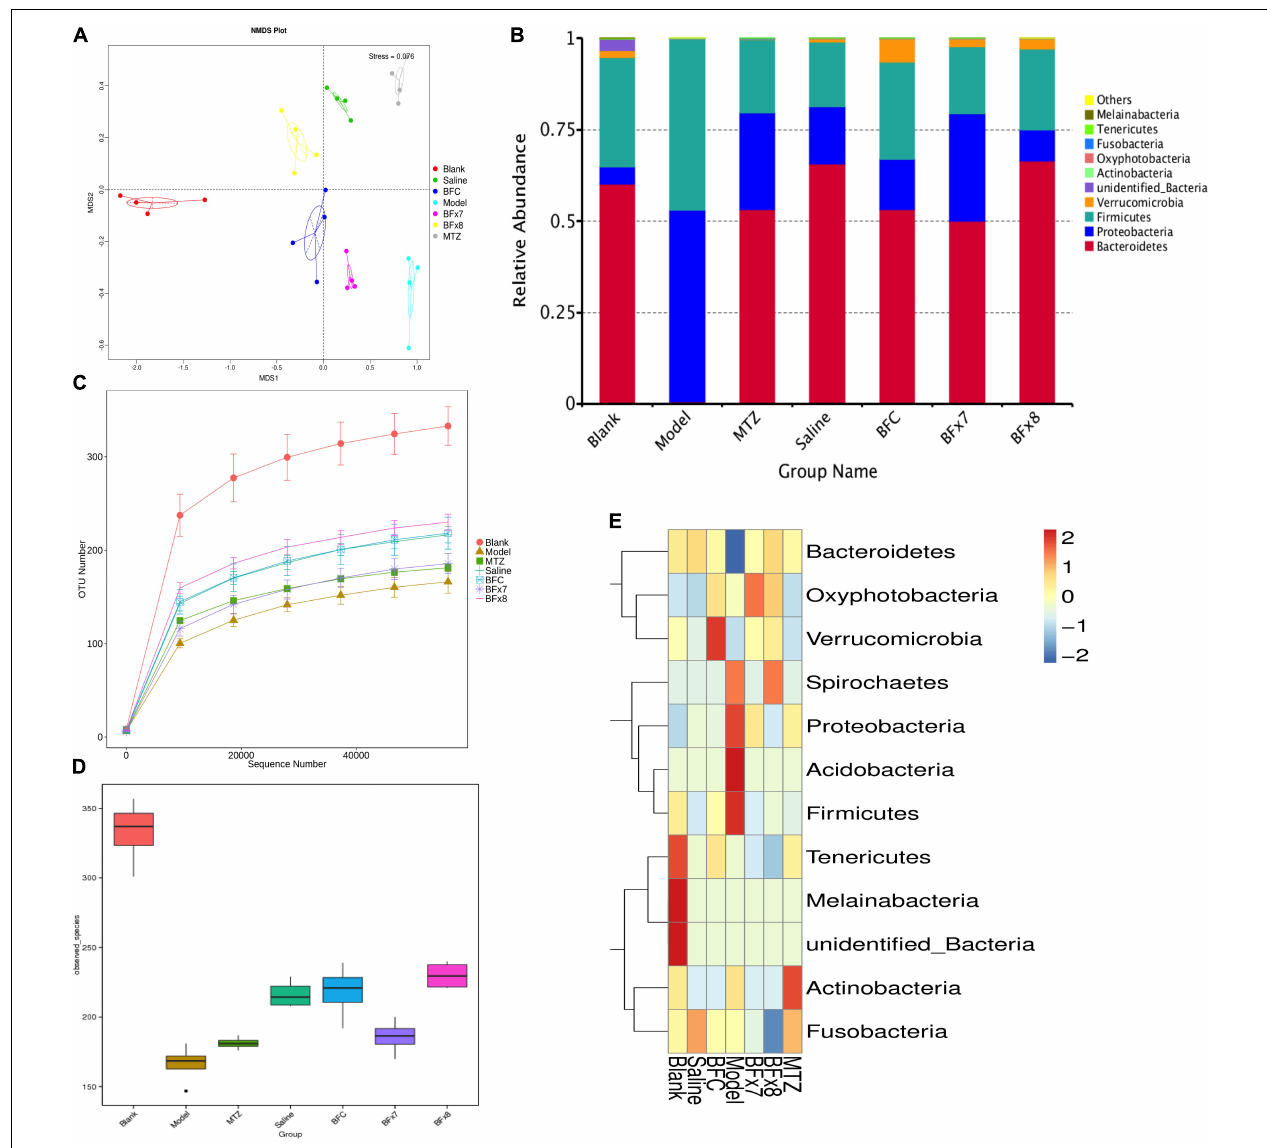
FIGURE 3 | Bacteroides fragilis ZY-312 regulates gut microbiota in the CDI mouse model. (A) Non-Metric Multi-Dimensional Scaling analyses based on OTUs in the Blank, Model, MTZ, Saline, BFC, BF × 7, and BF × 8 groups. (B) Relative abundance of the top 10 phyla in the gut microbiota of all groups. (C) Rarefaction curve showing the relative abundance of OTUs in all groups. (D) Observed species in all groups. (E) Cluster heat map indicating the richness of the top 12 phyla in all groups (Stress values < 0.2 indicates significant differences between samples). Mice in the Blank group were reared parallelly without any treatment. Mice in the CDI model group drank water with antibiotics including kanamycin (0.8 mg/mL), gentamicin (0.07 mg/mL), colistin (0.1135 mg/mL), metronidazole (0.43 mg/mL), and vancomycin (0.09 mg/mL) from D –9 to D –2, were intraperitoneally injected clindamycin (10 mg/kg) at D –1, orally challenged with 3 × 10 8 cfu of C. difficile spores from D0 to D2. Mice in the MTZ group were treated with metronidazole (1 mg/day) from the day of spore challenge (D0) to D5. Mice in the BFT groups were CDI model mice prophylactically treated with 1 × 10 7 cfu/day (BF × 7 group) or 1 × 10 8 cfu/day (BF × 8 group) B. fragilis from the onset (D –9) to the end of